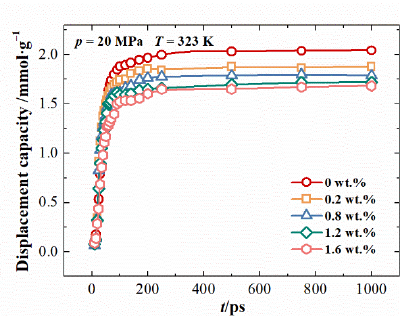
Energies 2021 , 14 , x FOR PEER REVIEW Figure 17. The displacement capacity of CH 4 in the reservoir with different water contents. Figure 17. The displacement capacity of CH